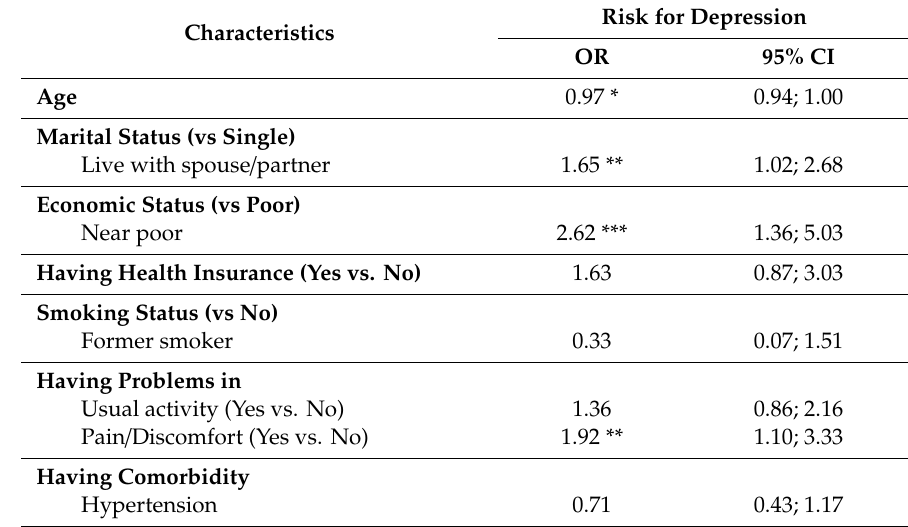
Table 4. Multivariate regression of factors associated with risk for